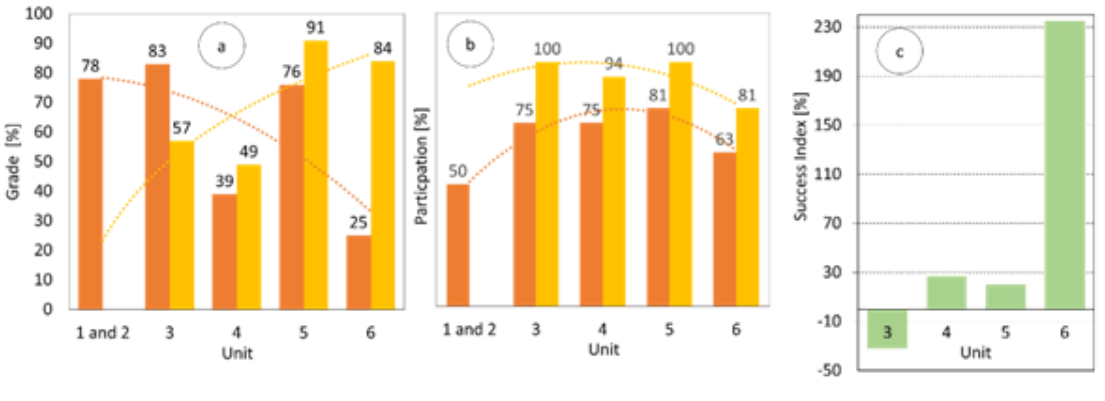
Figure 7. a) Percentage of student participation in the tasks throughout the course; b) Obtained grades for each unit; c) Obtained Success Index (I) for each